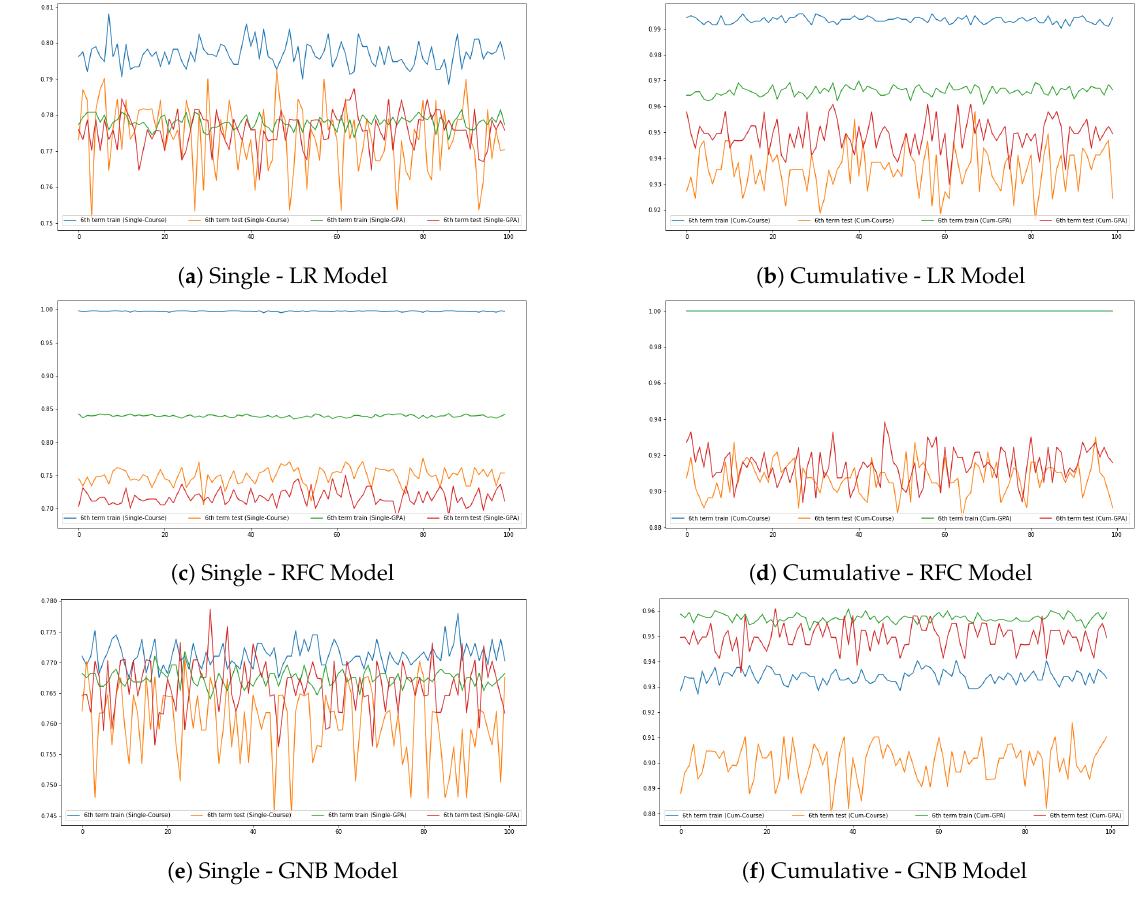
Figure 9. Variance plots of ML models for term